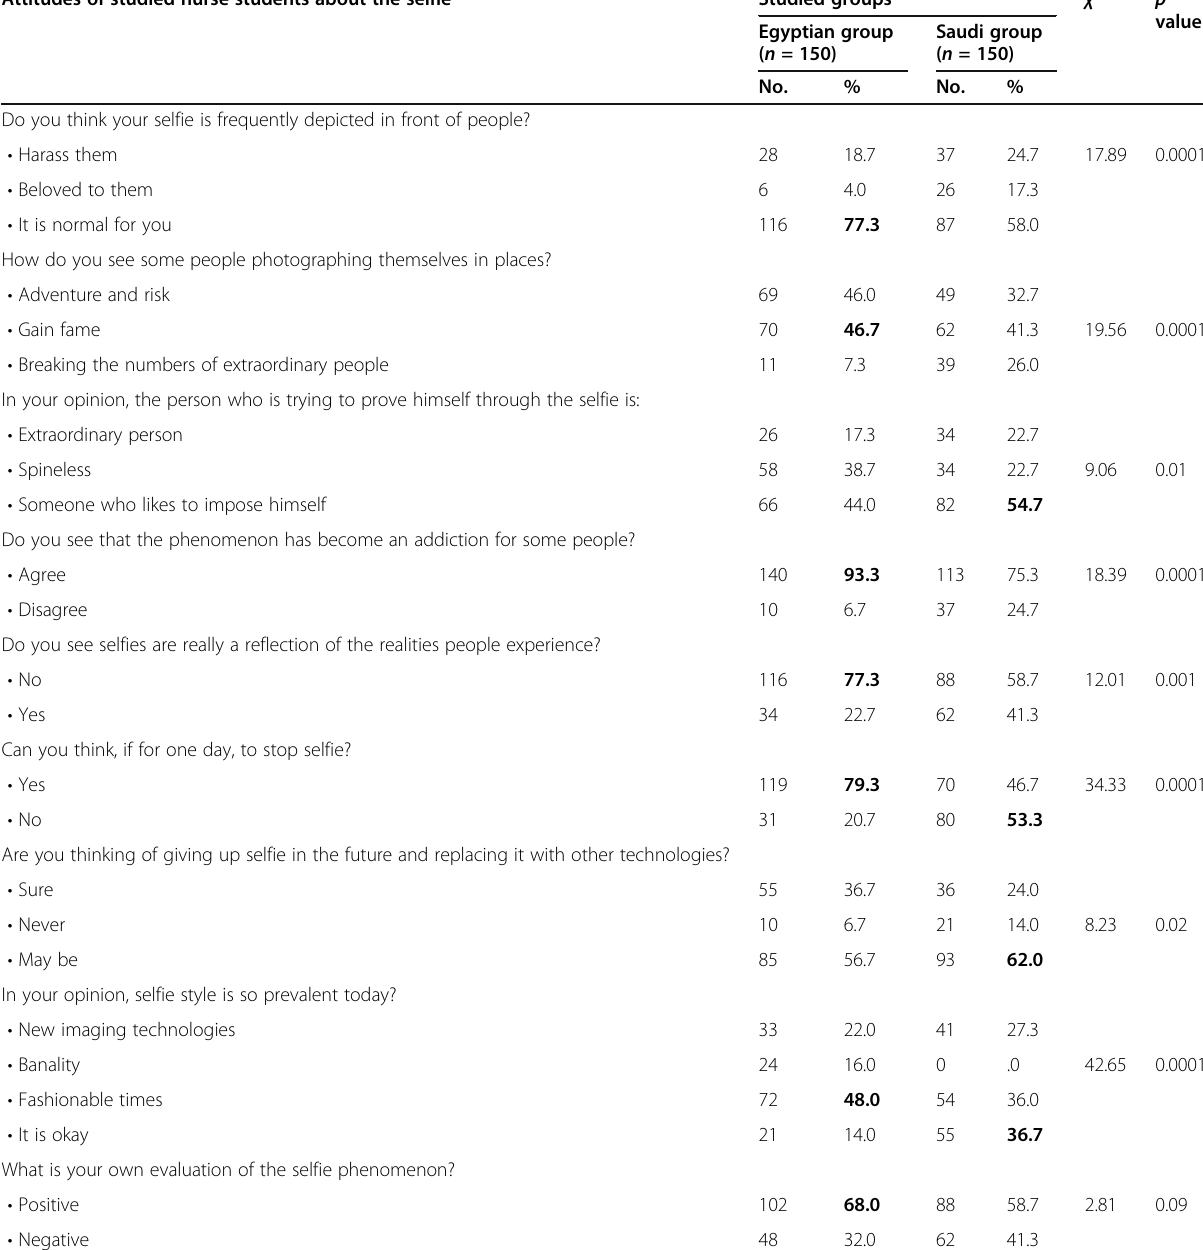
Table 4 Comparison between Egyptian and Saudi nursing students as regards their attitudes about selfie (each group n = 150) Attitudes of studied nurse students about the selfie Studied